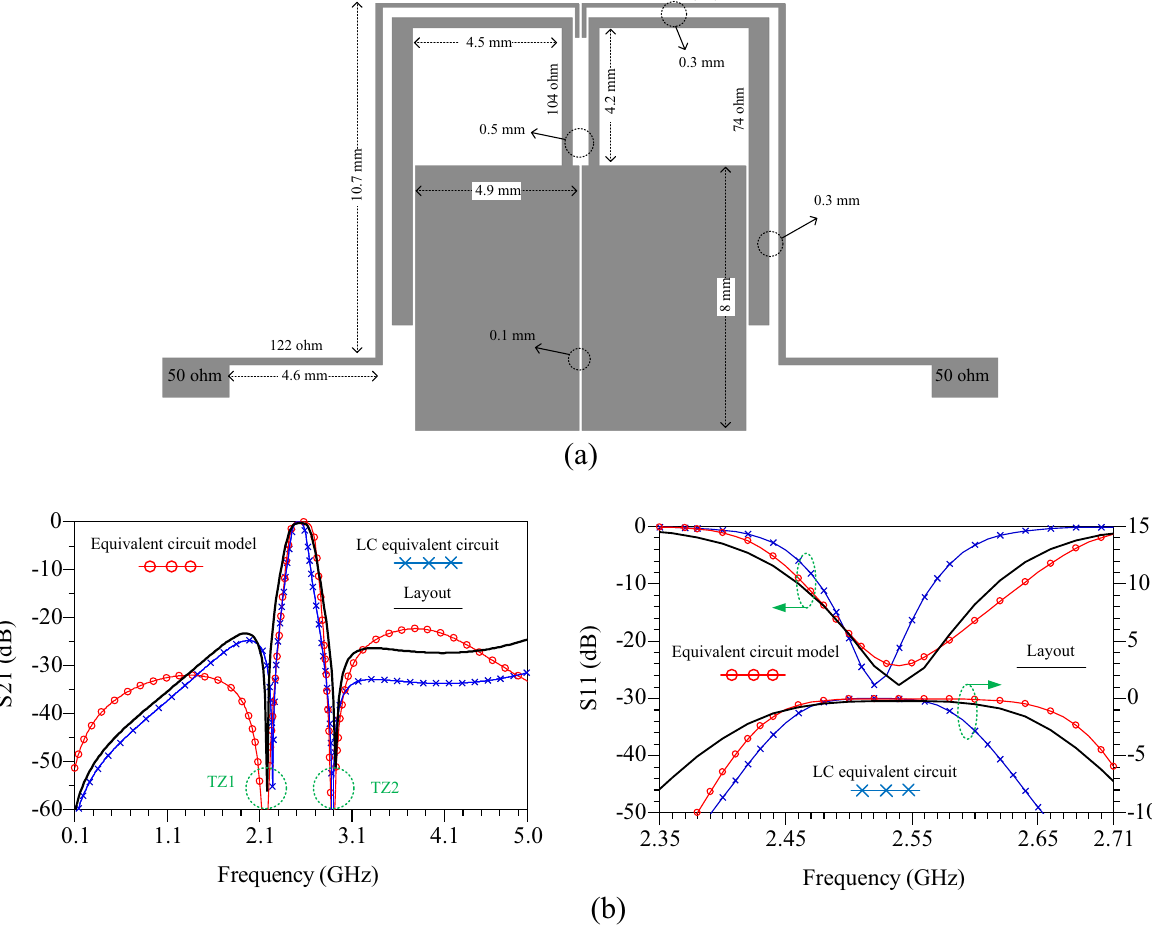
Figure 4. The proposed BPF, ( a ) layout, ( b ) simulation results S 21 and S 11 of equivalent circuit model, LC equivalent circuit and